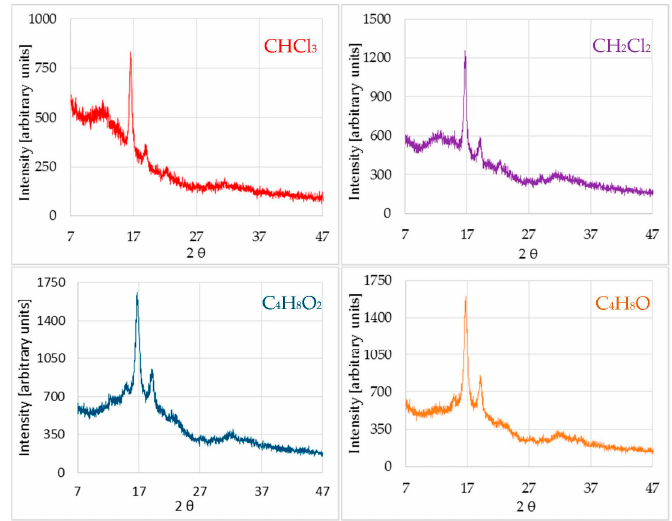
Figure 2. X-ray diffraction diagram of post-treated samples.